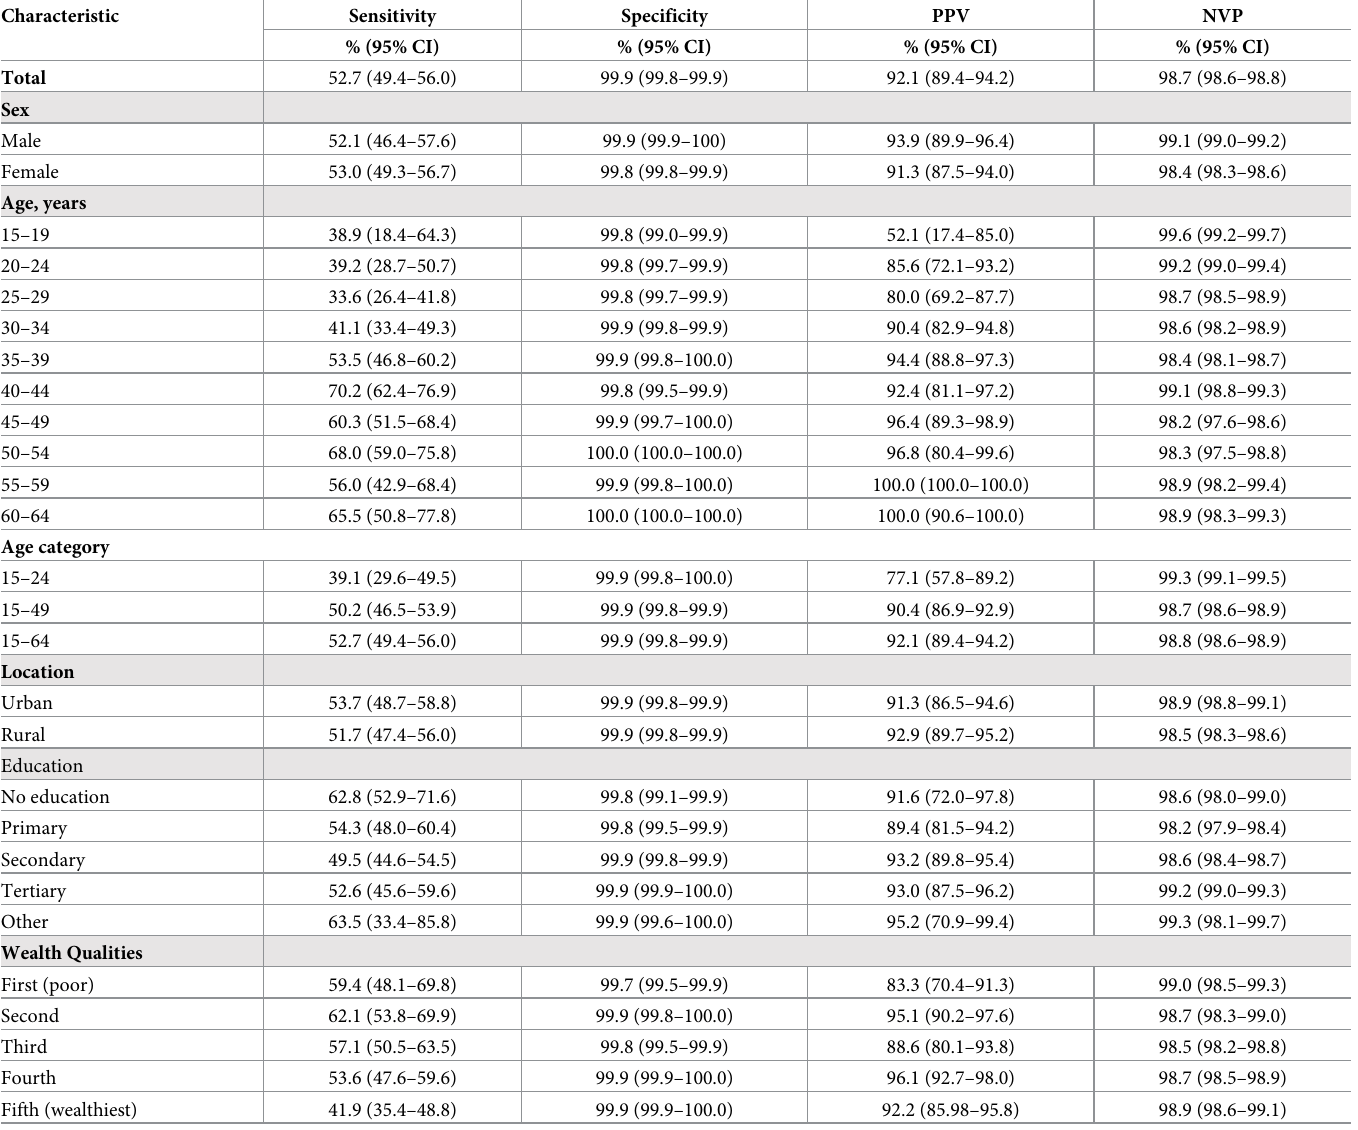
Table 3. Self-reported HIV status performance criteria (Nigeria HIV/AIDS and Indicator Survey